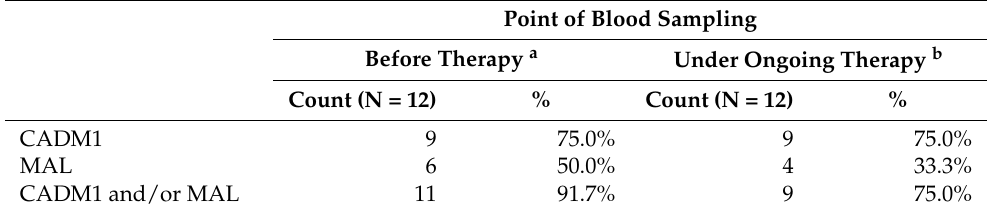
Table 4. CADM1, MAL, and CADM1 and/or MAL methylation status of blood samples from 24 cervical cancer patients in relation to point of blood